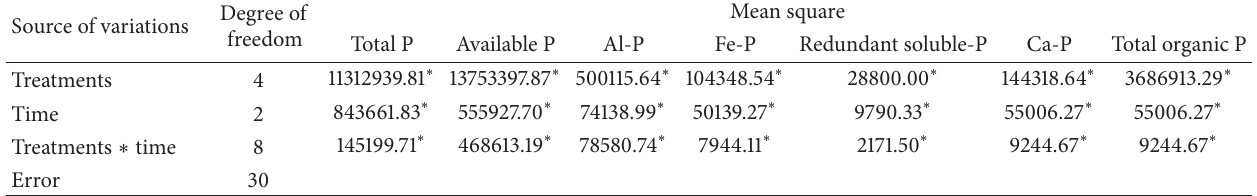
Table 5: Mean square values of analysis of variance (ANOVA) to evaluate the effects of treatments and time on the soil P fractions. Source of